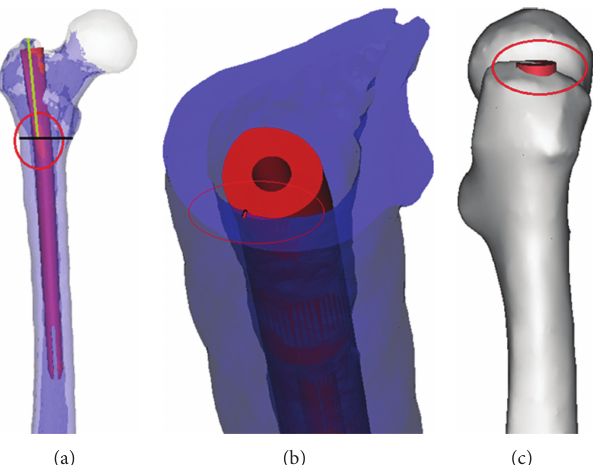
Figure 2: Proximal fitness of the implant with the femoral model. (a) The InterTan assembled with femoral model; the region within the red circle was the region of interest, the model was cut along the black line, and the distance between the top of the great trochanter and the center of the impingement region was depicted in green line. (b) The red line indicated the maximum thickness of the impingement area. (c) Within region the red circle was the proximal end of the implant protruding from the top of the great trochanter.